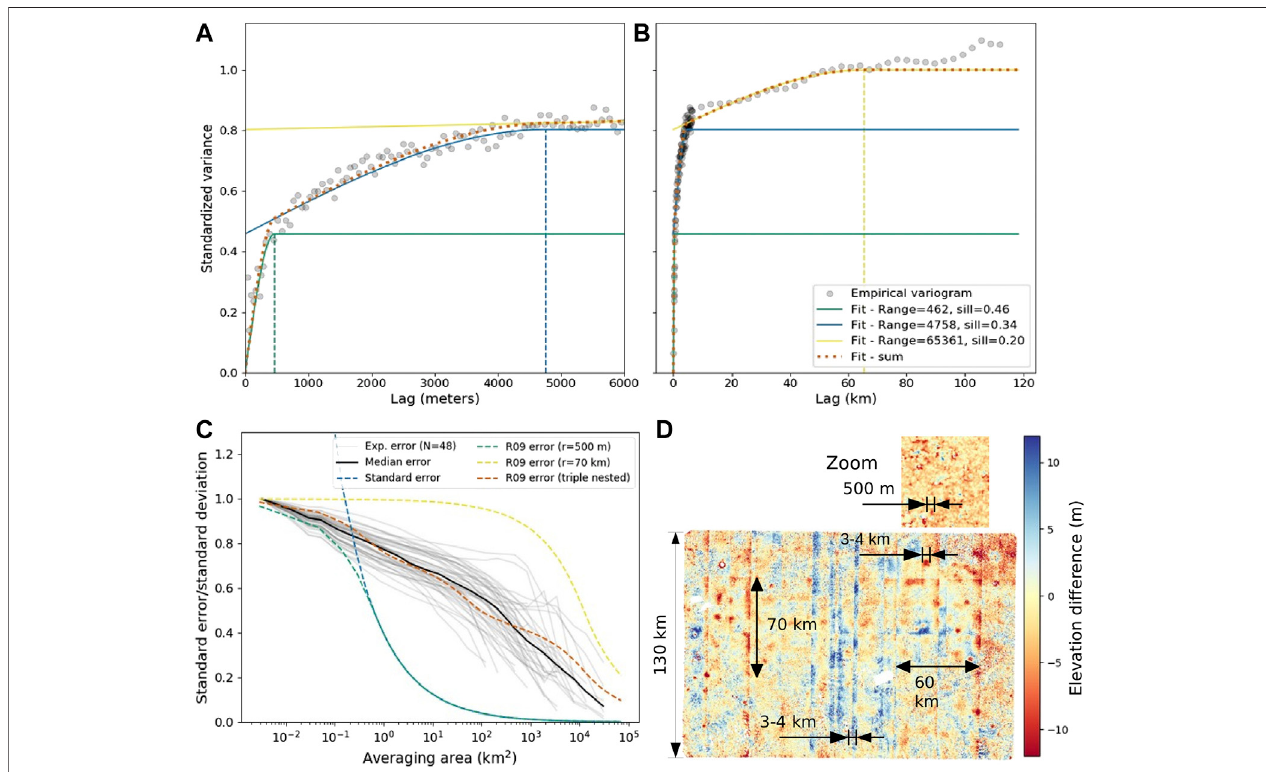
FIGURE9| SpatialcorrelationofDEMerrorintheKH-9MCDEMsandscalingforareaaveraging.Observed(graydots)andmodeled(lines)variogramsforelevation differences between 48 KH-9 MC DEMs and ArcticDEM mosaic over Alaska for (A) short lag distances ( < 6 km) and (B) all lag distances. The best fi t variogram model (orange dashed lines) is the sum of three nested spherical models (green, blue and yellow lines). (C) Empirical standard error of the mean (SEM) as a function of the averaging areafor all 48DEM differences(gray lines)and themedian values (black line) compared toseveralanalyticalestimates (R09 refersto Rolstad et al.(2009) model for corresponding range r) and our best- fi t triple-nested variogram model (orange dashed line). (D) Sample elevation difference map for KH-9 MC pair DZB1212- 500129002/003 (essentially ice-free area), with typical artifact length scales